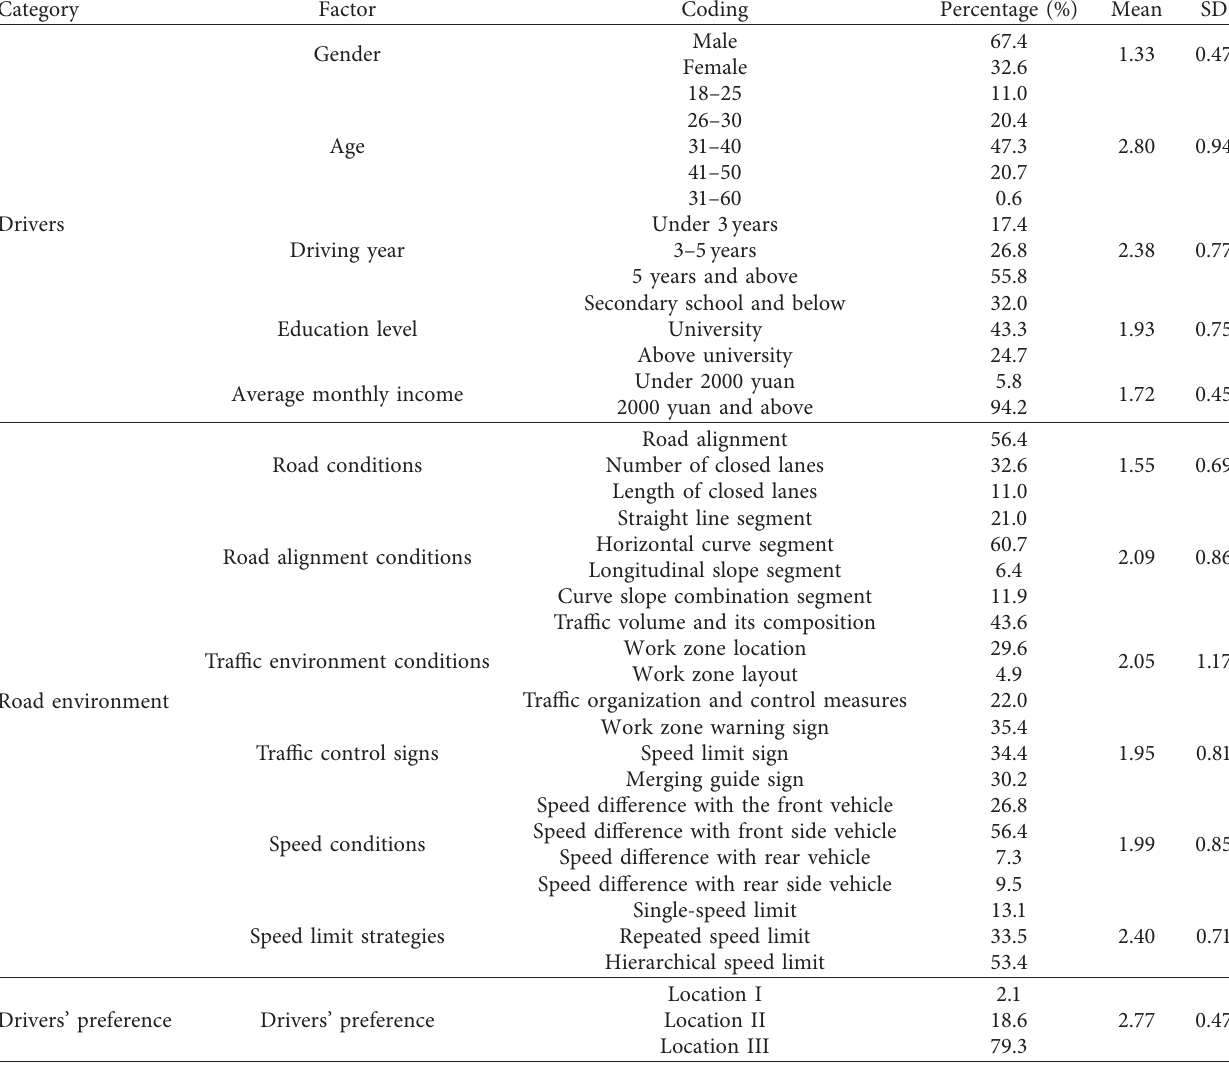
Table 1: Characteristics and descriptive statistics of